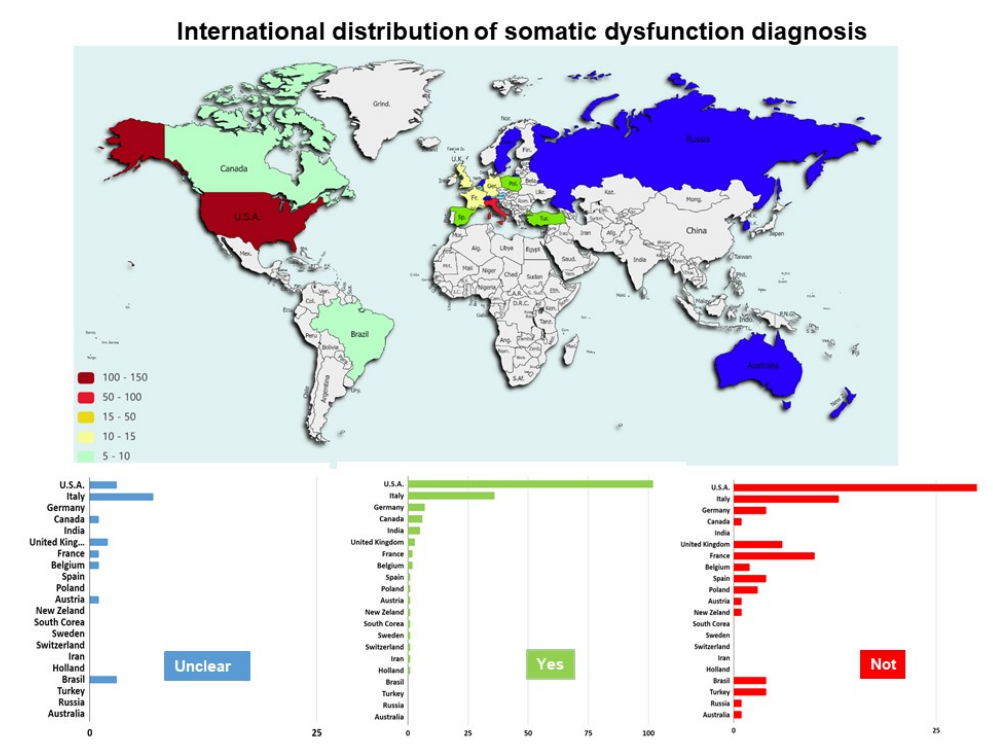
Figure 3. International distribution of somatic dysfunction diagnosis, reported as the number of studies investigating (Yes) or not (Not) the somatic dysfunction for each country. Studies for which it was not clear the diagnosis of somatic dysfunction were reported (Unclear).